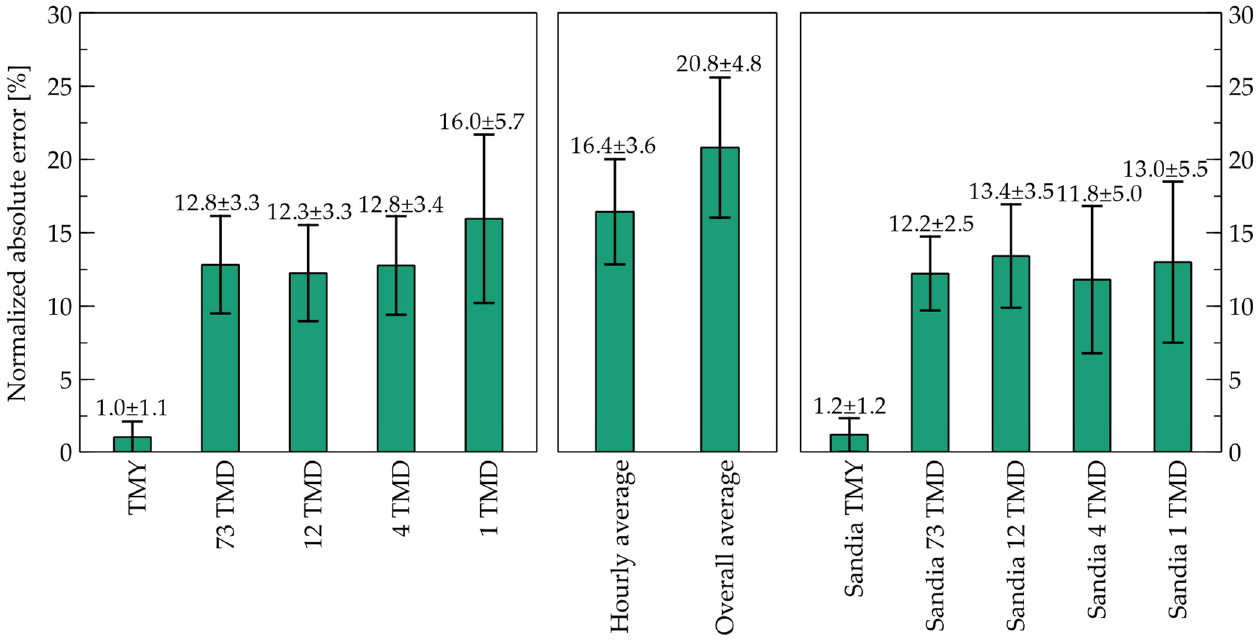
Figure 3. Normalized mean absolute errors of produced electricity on different weather summarization.